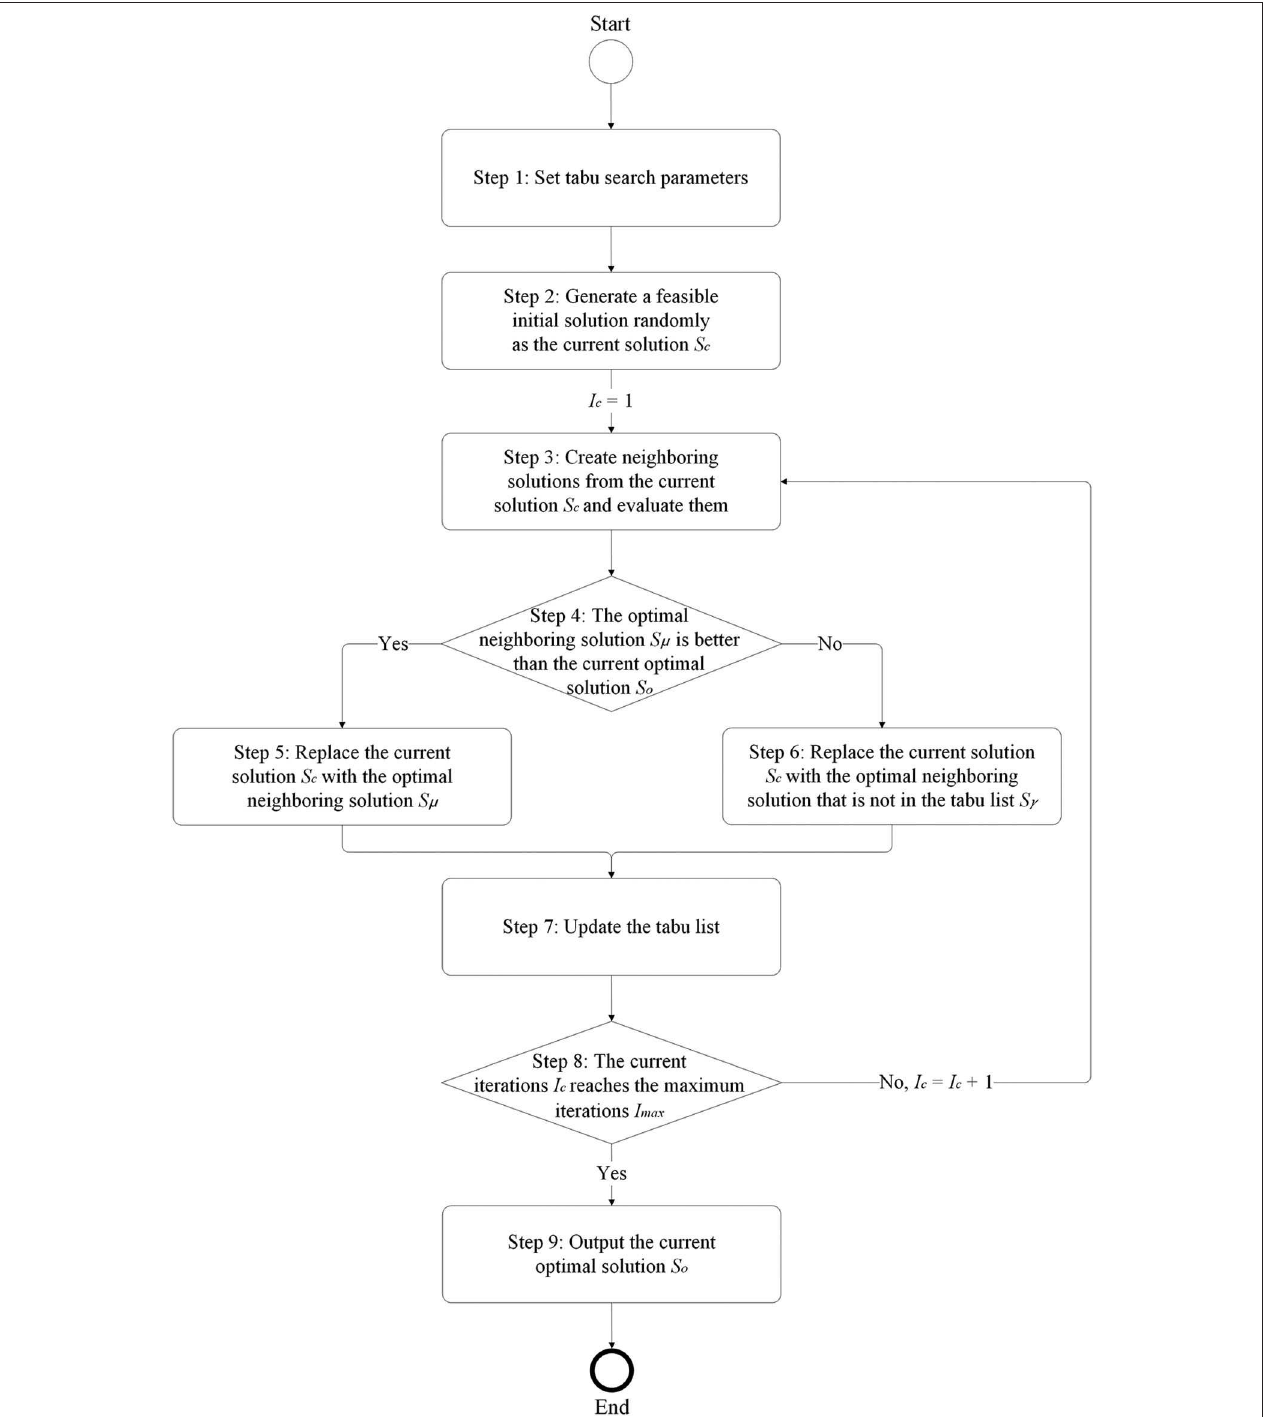
FIGURE 2 | Procedure of the applied tabu search.